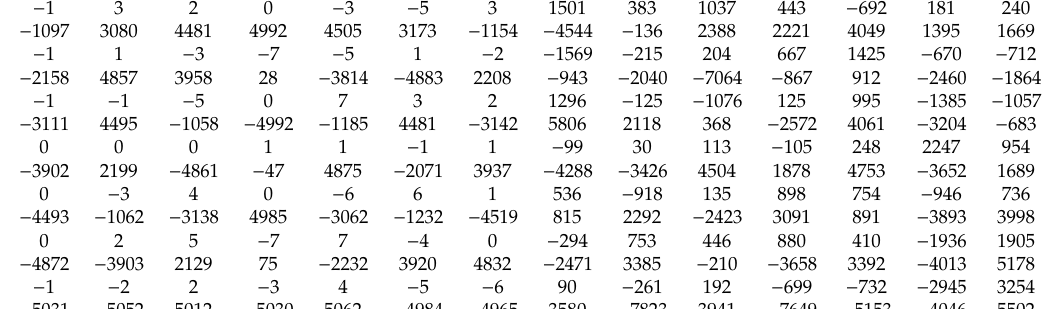
Table 5. Normalized mode shapes ( × 10 4 ).